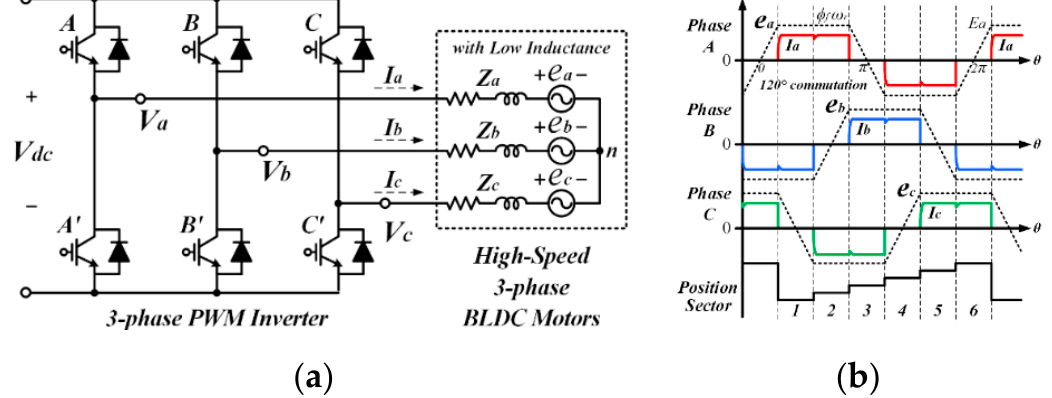
Figure 1. Three-phase high-speed brushless DC (BLDC) motor inverter system: ( a ) equivalent circuit; ( b ) three-phase current and back-EMF waveforms.